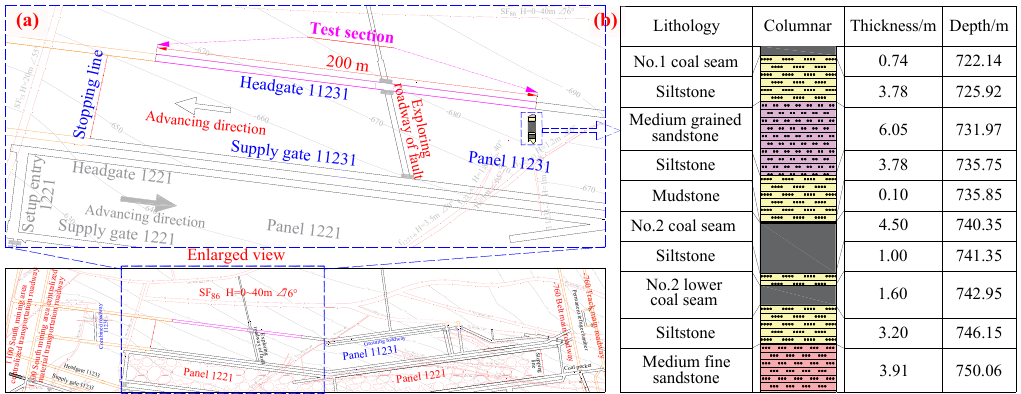
Figure 2. Location of panel 11231 and the columnar section of the coal and rock strata. ( a ) Location of panel 11231; ( b ) Columnar section of the coal and rock strata.